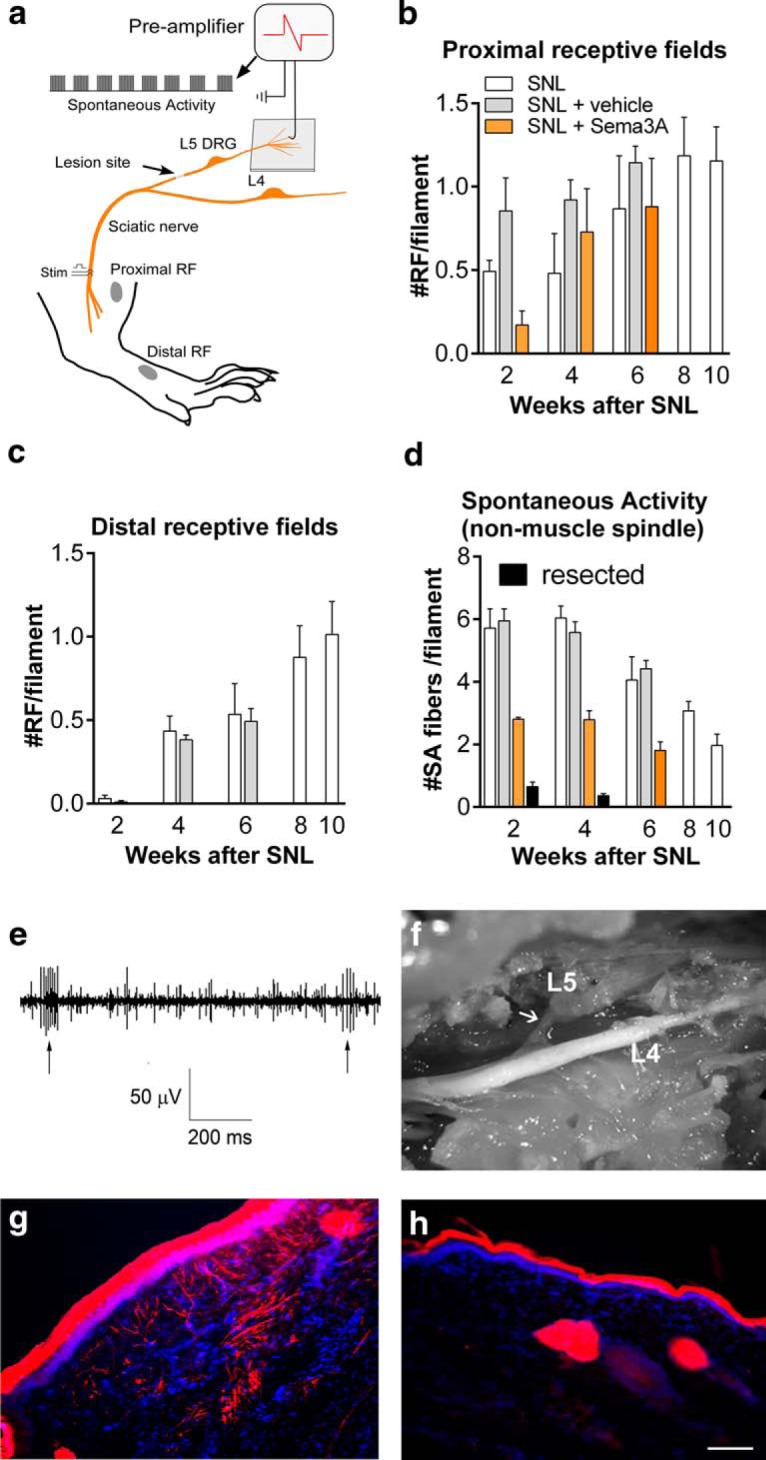
Regeneration of L5 spinal nerve is functional and can be reduced by semaphorin 3A. a, Schematic of the in vivo fiber recording setup. Filaments were teased out of the dorsal root, disconnected centrally. After observing spontaneous activity, receptive fields were examined by applying mechanical stimuli to proximal (above the knee) and distal (lower leg and paw) regions. b, c, Average number of proximal (b) and distal (c) receptive fields per filament detected at the indicated times after SNL, SNL plus perfusion of the injury site with vehicle, or SNL plus perfusion of the injury site with semaphorin 3A (“Sema3A”). In c, values for semaphorin 3A group are zero. d, Average number of spontaneously active fibers per filament (excluding normal muscle spindle and joint receptor activity) detected in the same experiments. N = 3 or 4 rats/group with 72 to 116 filaments per group, except for the resected POD14 group, which contained only two animals. e, Example of spontaneous activity, and activity evoked by mechanical stimulation (Stim) of a receptive field (RF; arrows). f, In situ image of regenerated nerve on day 28 in animal perfused with semaphorin 3A (tubing removed before image was taken); note that the segment is thin and fine (compare Fig. 1b; observation was repeated in eight rats). g, Paw cross-section showing dextran biotin-labeled fibers (red) observed 28 d after SNL in a vehicle-perfused rat (repeated in four rats). h, Dextran biotin-labeled fibers were absent in paw cross-sections obtained from semaphorin 3A-perfused rat (repeated in four rats). Scale bar, 100 µm.